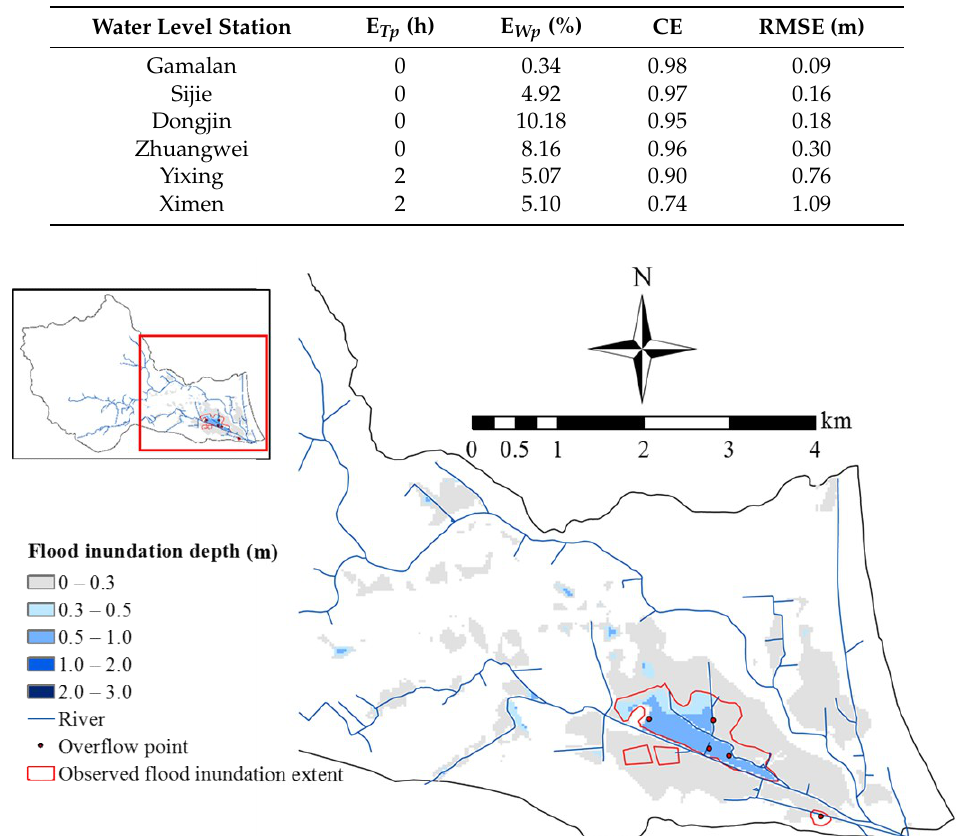
Figure 6. Comparison of simulated and observed flood inundation extents.